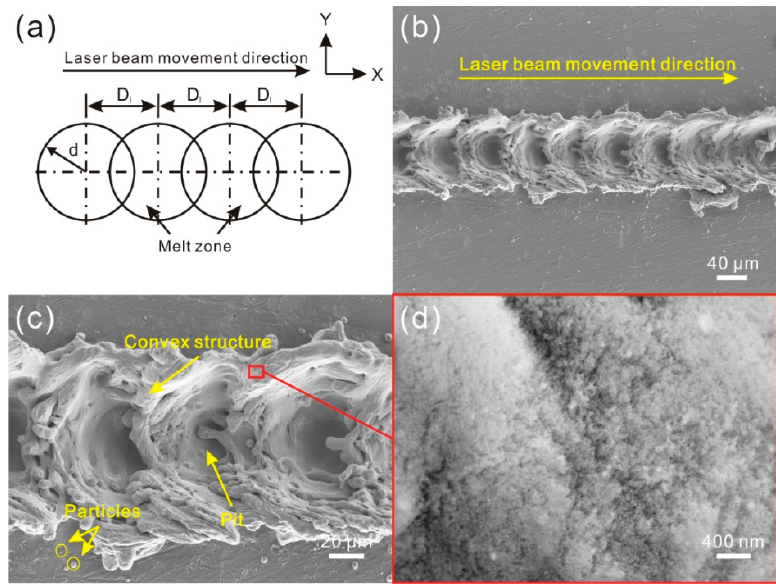
Figure 4. ( a ) Schematic of overlap degree of molten pools (overlap of each melting zone, i.e., d ≤ D 1 < 2d); ( b ) SEM image of the microstructure on alloy surface (laser beam pulse frequency of 8000 Hz, laser beam scanning speed of 0.4 m/s); ( c , d ) high-magnification SEM image of the microstructure.